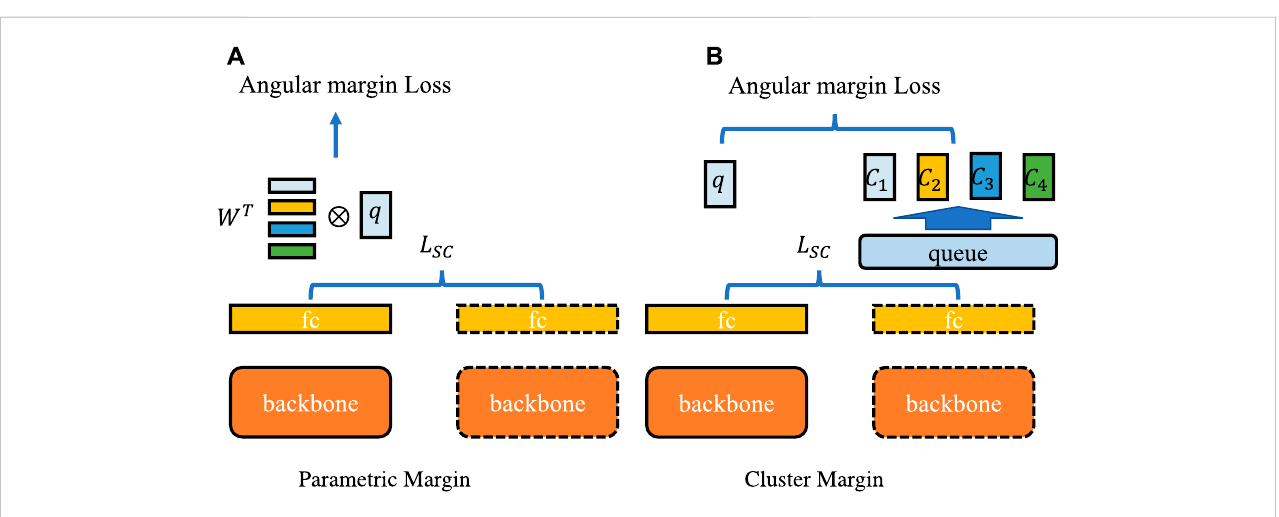
FIGURE 9 Comparison of margin-based methods. The backbone network is shared between the fi rst and second steps, and the fully connected layer outputs queriesandkeys.Thedashedlinesindicatethatalllayersareupdatedinamoving-averagemanner. L SC representsSupConloss. (A) representsthe “ parametric margin ” schema which applies angular margin loss between query embedding and additional parametric weights W . (B) is the “ cluster margin ” method that clusters all key embeddings into four class centers { C 1 , C 2 , C 3 , C 4 } according to class label, and applies angular margin between query embeddings and cluster centers.